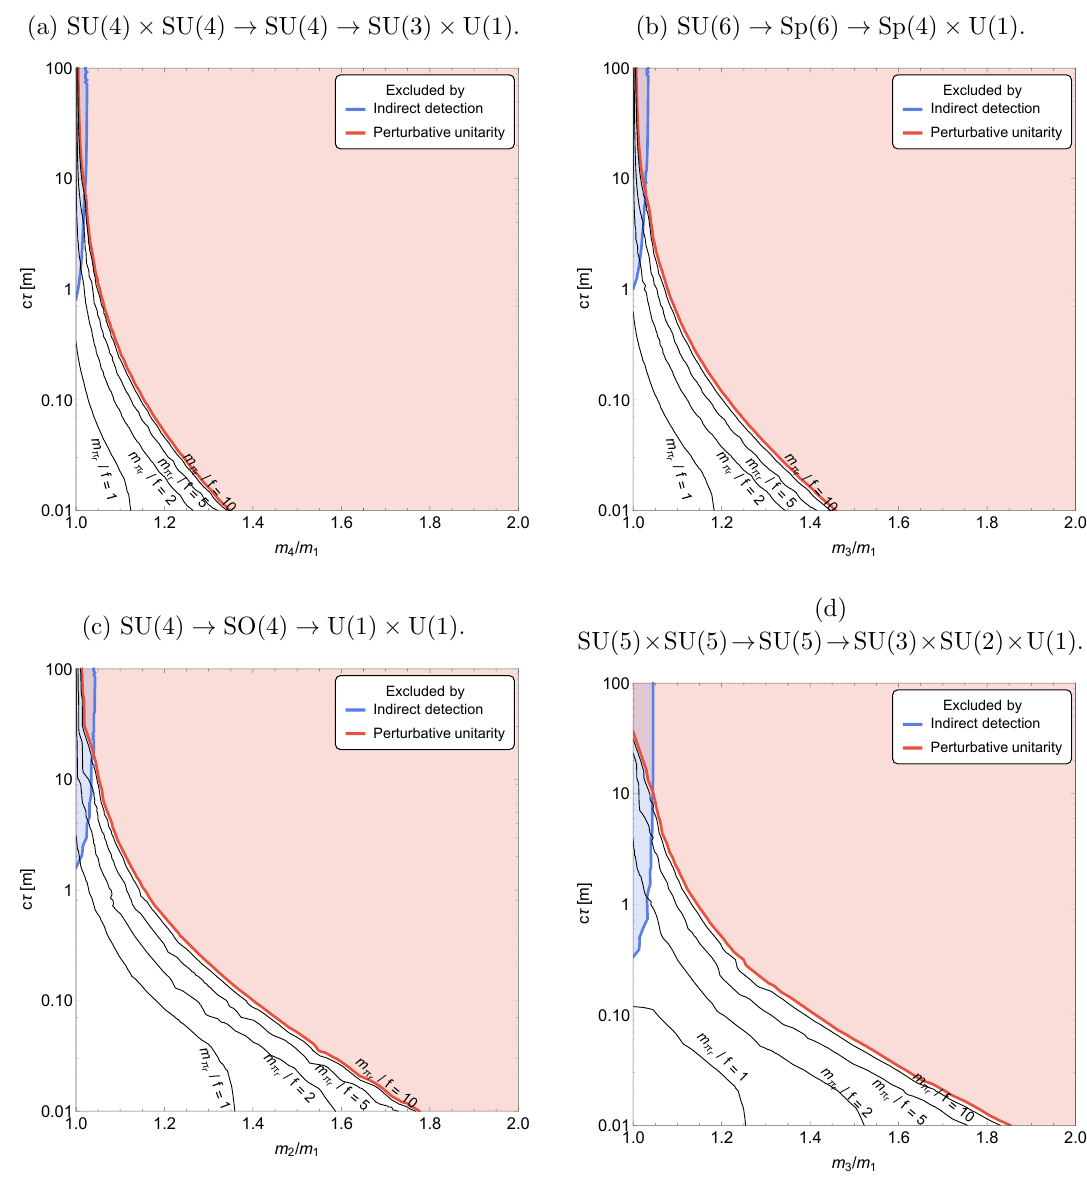
Figure 7. Allowed region of parameter space for di(cid:11)erent benchmarks of category II. For (a), (b), (c) and (d), the masses of the ( 8 ; 0) of SU(3) (cid:2) U(1), the ( 5 ; 0) of Sp(4) (cid:2) U(1), the ( (cid:6) 1 ; 0) of U(1) (cid:2) U(1) and the ( 8 ; 1 ; 0) of SU(3) (cid:2) SU(2) (cid:2) U(1) are respectively set to 75 GeV. The black contour lines represent constant values of m (cid:25) =f , where m (cid:25) is simply the representation mass kept r r constant, i.e. 75 GeV. The blue region is excluded by indirect detection DM searches, while the red one by perturbative unitarity